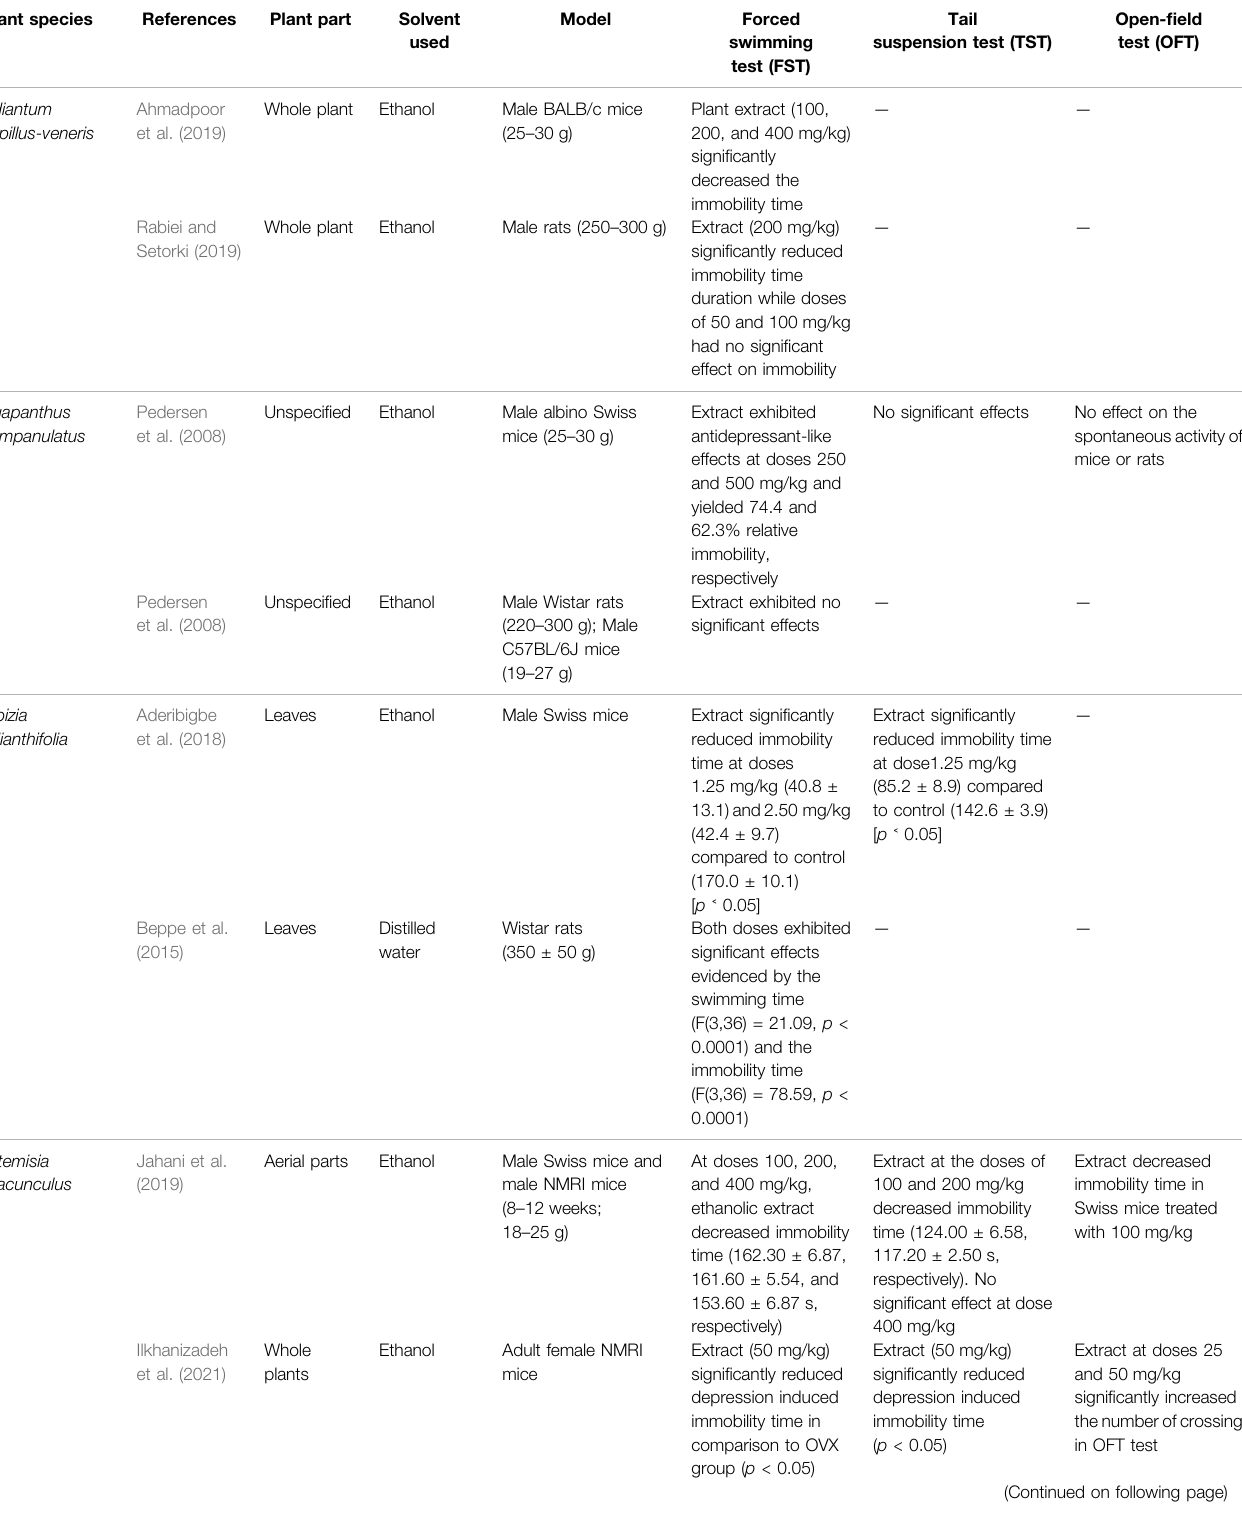
TABLE 5 | Different in vivo assays utilized for investigating the antidepressant potential of medicinal plants. Plant